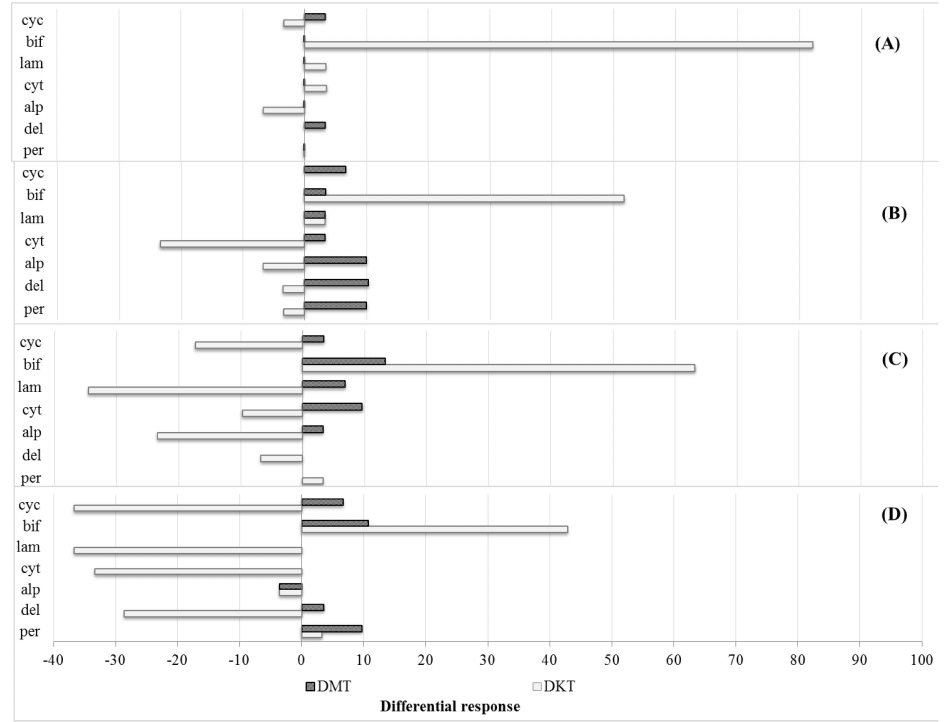
Figure 2. The differential response of Stomoxya calcitrans (( A ) Songkhla, ( B ) Phatthalung) and Stomoxys indicus (( C ) Phatthalung, ( D ) Satun) exposed to pyrethroids (per = permethrin, del = deltamethrin, alp = alphacypermethrin, cyt = cypermethrin (tec.), lam = lambdacyhalothrin, bif = bifenthrin, cyc = cypermethrin (com.)) at two knockdown observations (60 min and 30 min after exposure) and mortalities (24 h and 12 h); DMT: differential mortality time, DKT: differential knockdown